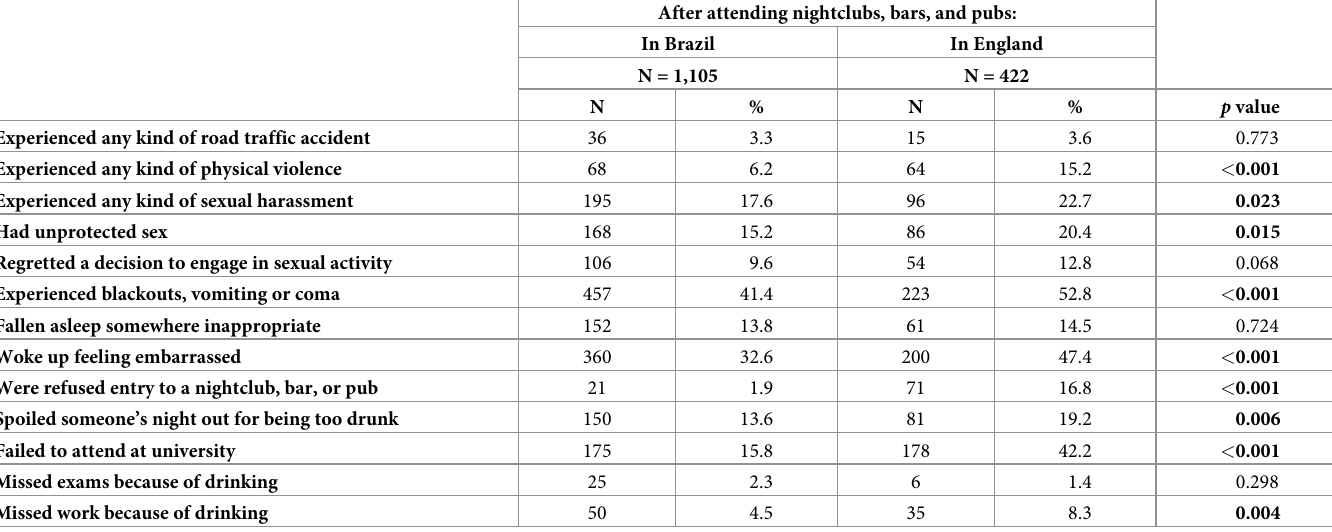
Table 5. Brazilian and British students’ past 12 months alcohol-related harms experiences after attending nightclubs, bars, and pubs.